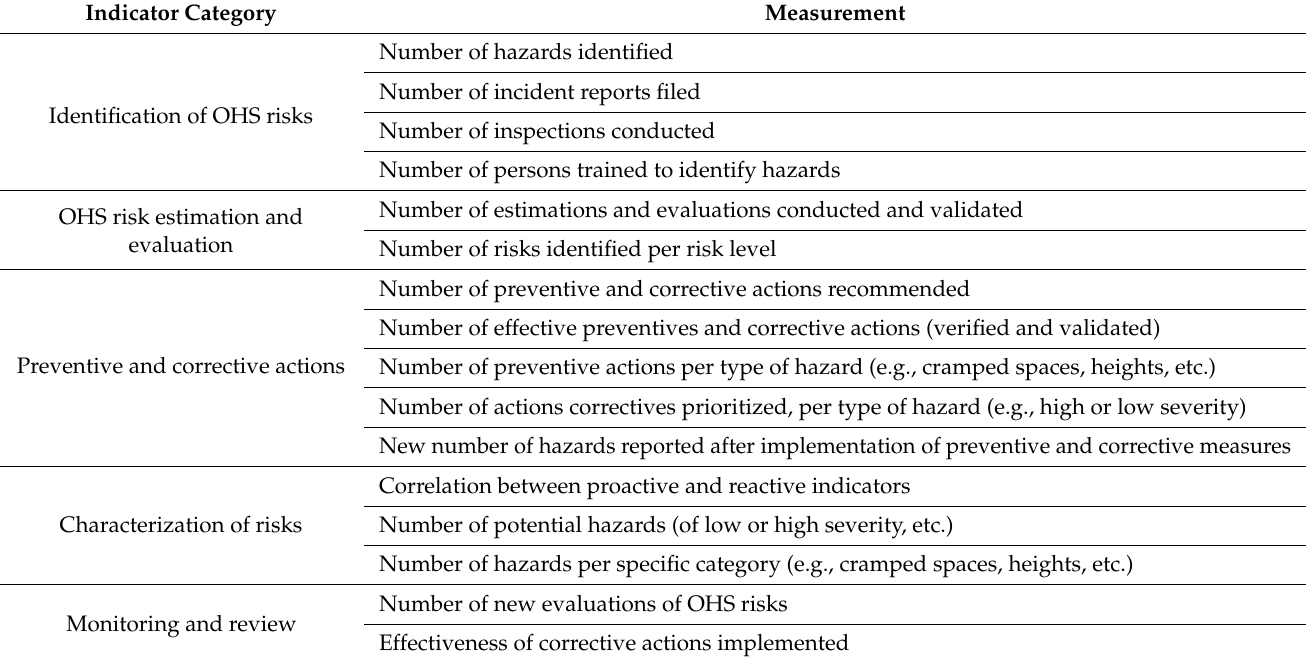
Table 14. Risk management process maturity indicators